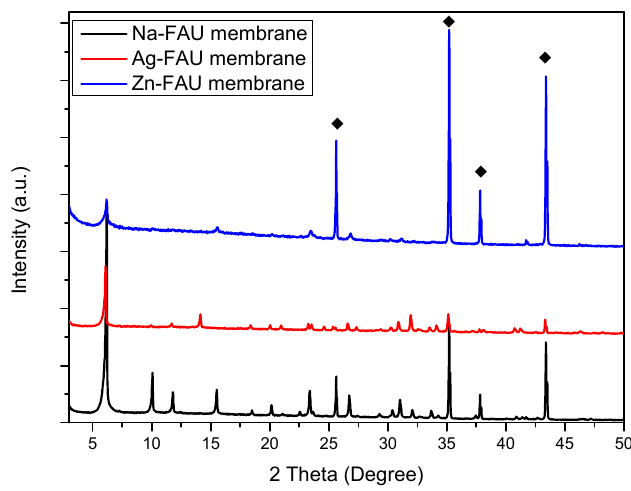
Figure 6. XRD patterns of Na-FAU membrane on α -Al 2 O 3 supports, silver exchanged FAU membrane and zinc exchanged FAU membrane. Black diamonds indicate the peaks of α -Al 2 O 3 support.